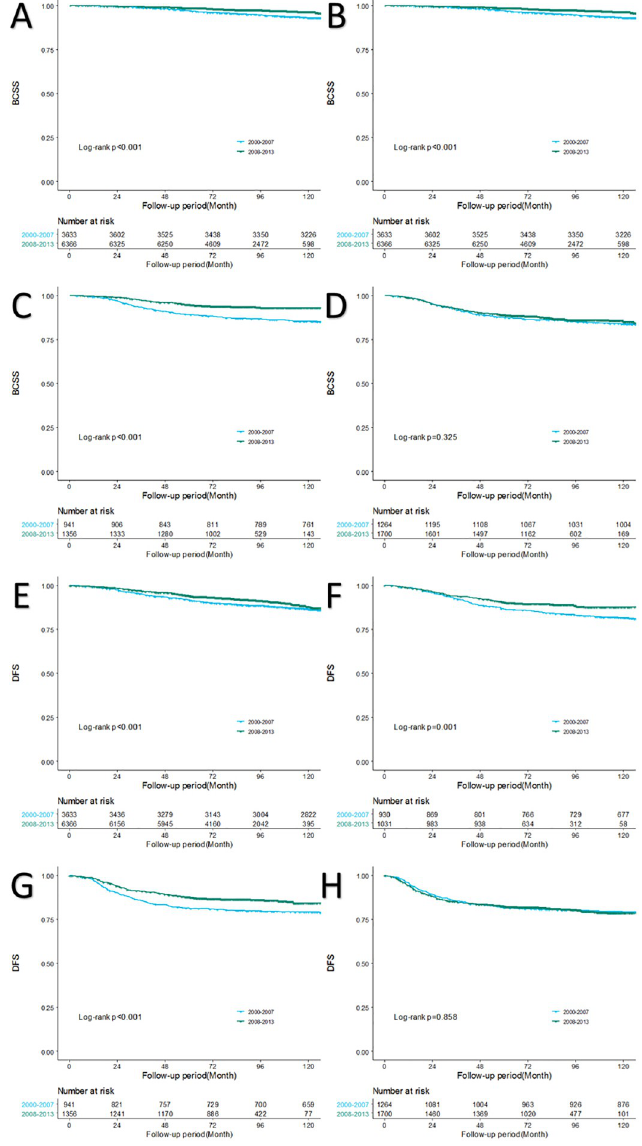
Fig 2. Chronological changes of breast cancer-specific survival (BCSS) and disease-free survival (DFS) in Korean breast cancer patients; subgroup analysis by subtype. (A) BCSS of subtype HR(+)/HER-2(–). (B) BCSS of subtype HR(+)/HER2(+). (C) BCSS of subtype HR(–)/HER-2(+). (D) BCSS of subtype HR(–)/HER2(–). (E) DFS of subtype HR(+)/HER2(–). (F) DFS of subtype HR(+)/HER2(+). (G) DFS of subtype HR(–)/HER2(+). (H) DFS of subtype HR (–)/HER2(–). HR: hormone receptor; HER2: human epidermal growth factor receptor 2.